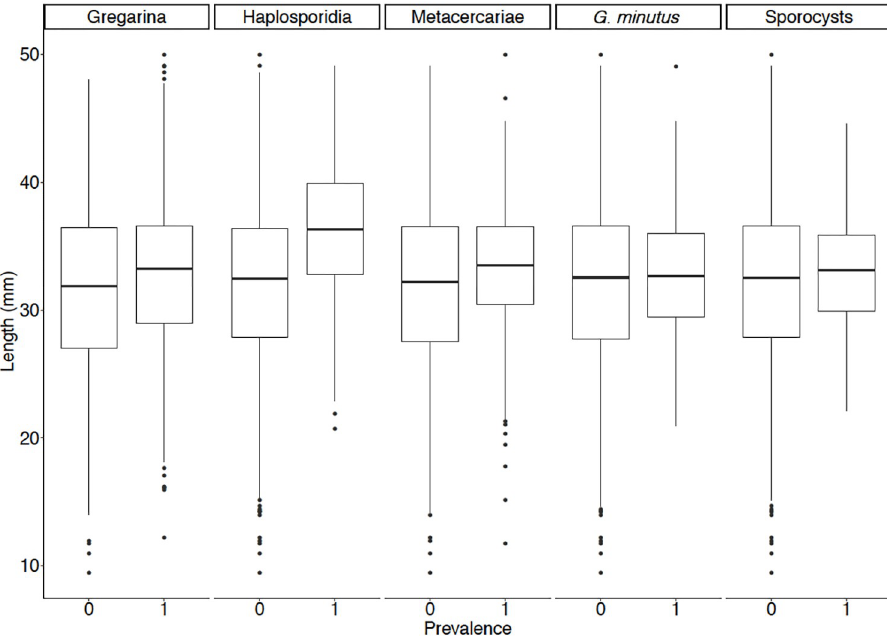
Fig 5. Boxplots demonstrating the relationship between pathogens and cockle shell length. Absence of pathogens is indicated by 0 and presence is indicated by 1. The boxplots display the median values, boxes extend from the 25 th to 75 th percentile of each group’s distribution of values, and whiskers show the largest and smallest values within 1.5 times the interquartile range. Outliers are indicated by individually plotted points.